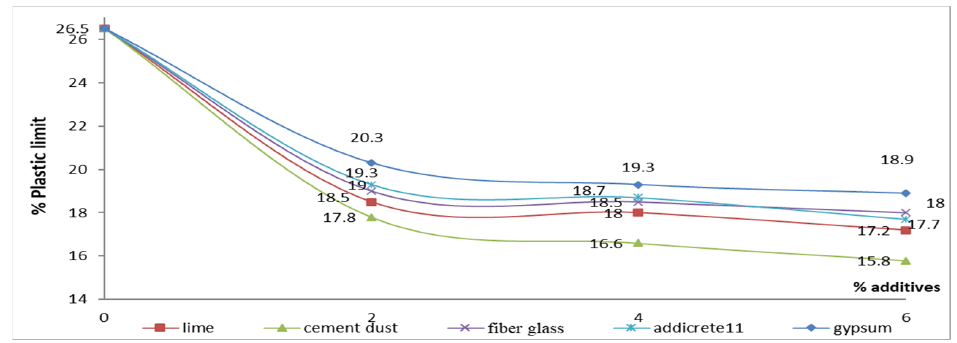
Figure 17. Effect of additives on the plastic limit.